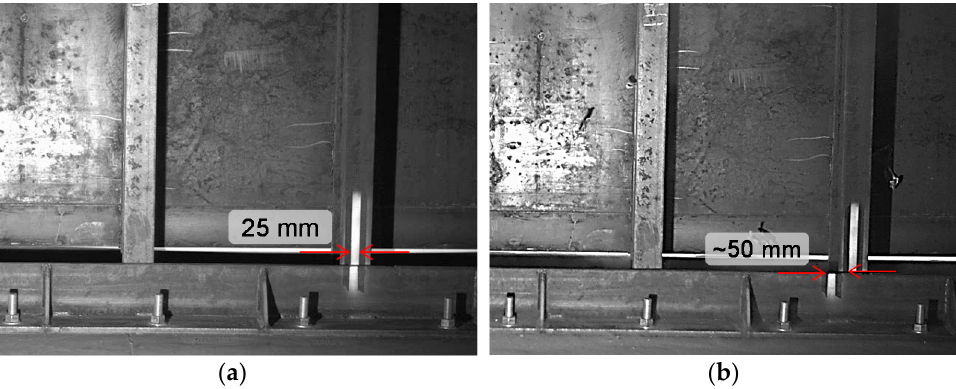
Figure 21. Test 2—Close ‐ up views of the base sliding connection (south to north direction) of the first ‐ floor curtainwall façade at the west elevation of the building (high ‐ speed camera inside the building looking west): ( a ) Time = 0 ms; ( b ) Time = 125 ms after detonation.